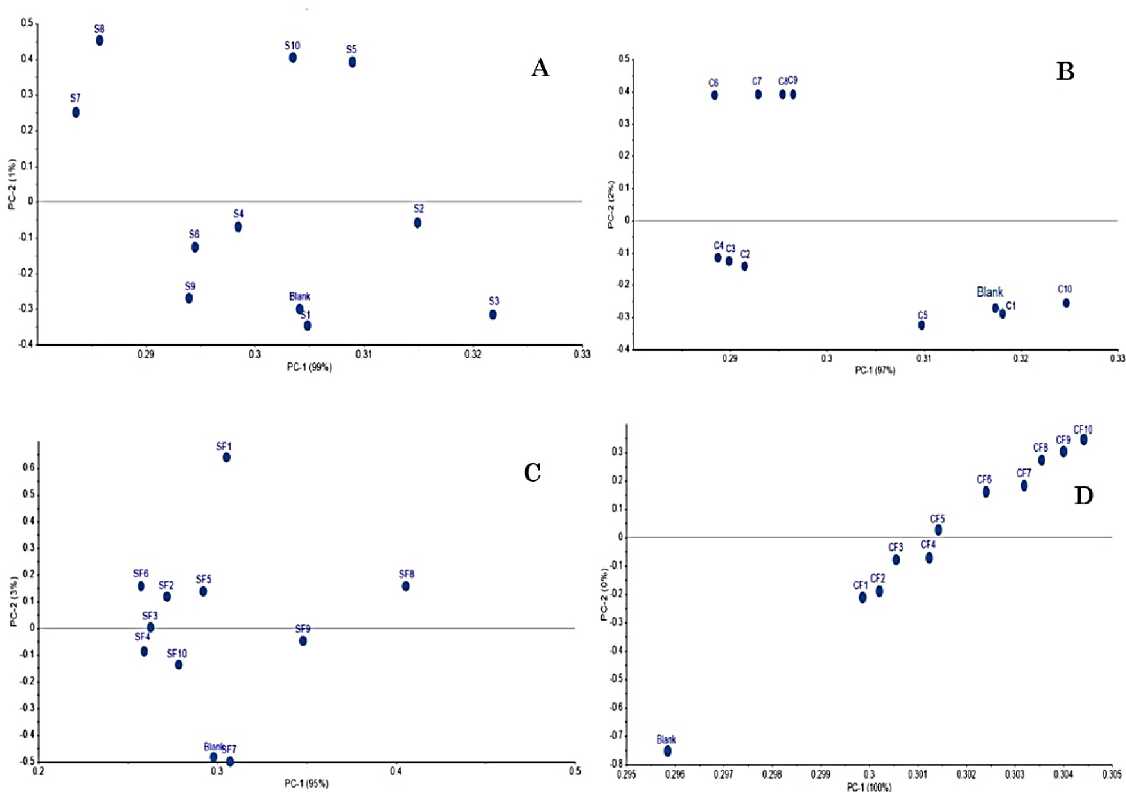
Fig 4. PCA plots for the obtained FTIR spectra of (a) sunflower oil (S) after heating for 10 days, (b) corn oil (C) after heating for 10 days, (c) sunflower oil after French fries frying (SF) for 10 days, (d) corn oil after French fries frying (CF) for 10 days.